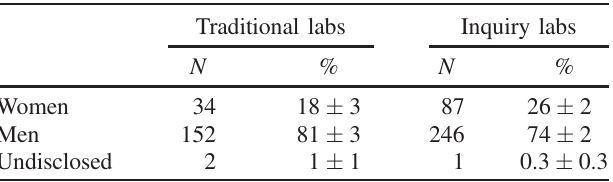
sured in this study. Errors were computed using standard error for population fractions, shown in Eq. (1). In all, 143 students were observed across multiple lab periods, resulting in 522 unique student profiles.